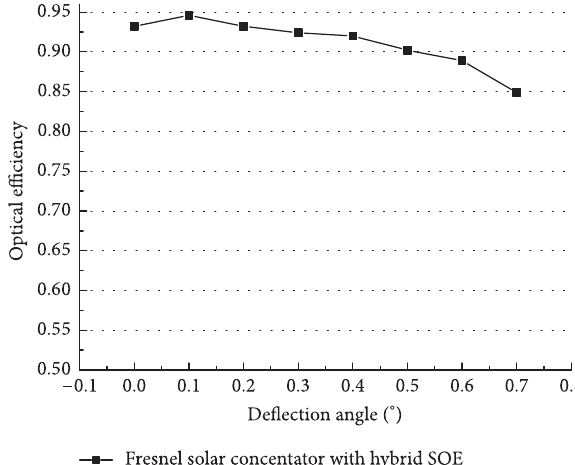
Figure 4: Optical efficiency with different deflection